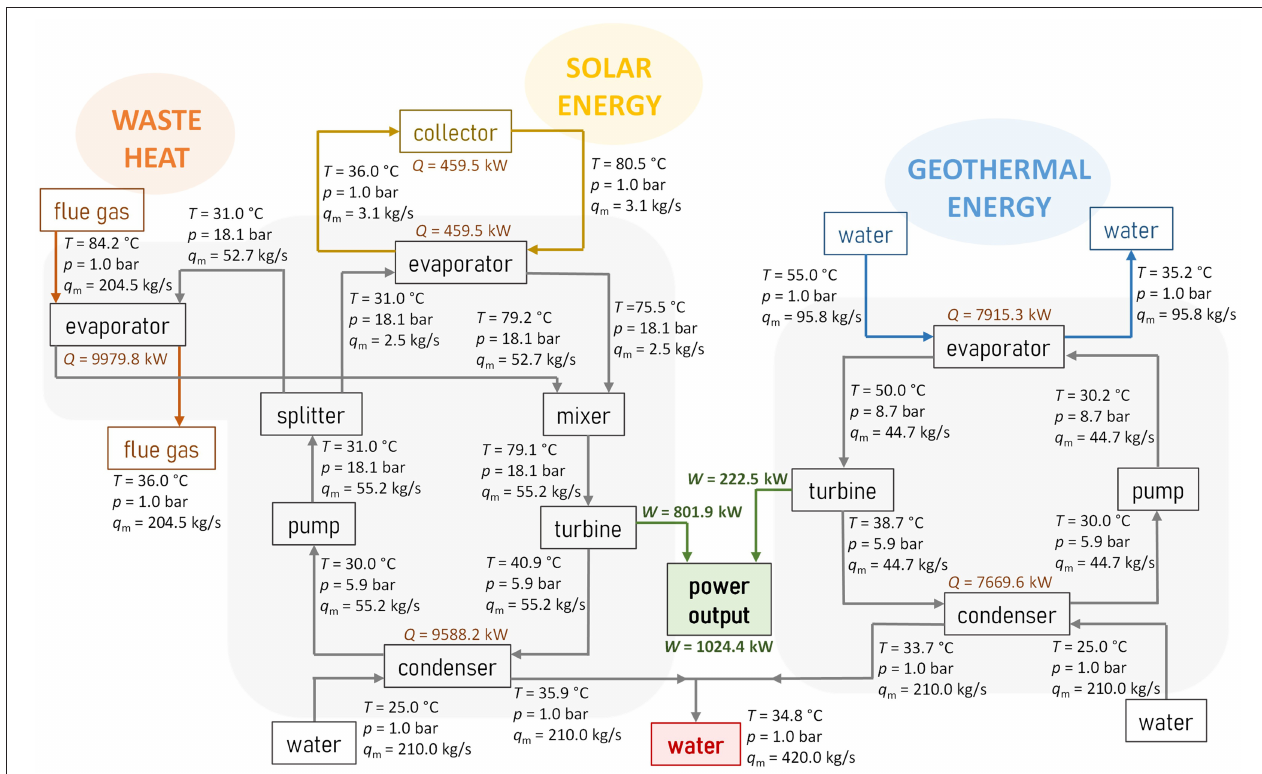
FIGURE 9 | Optimized ORC system when maximizing power output for working fluid